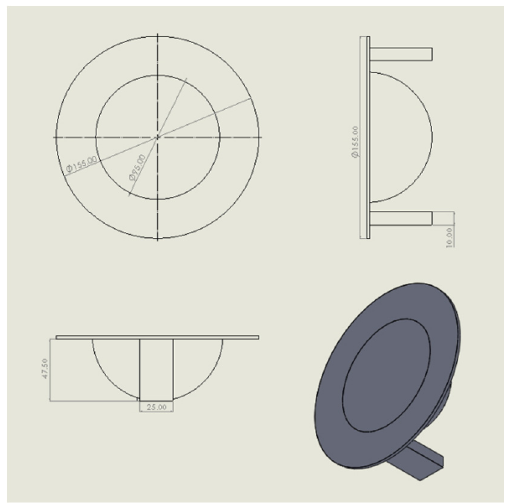
Figure 1. Three-dimensional engineering drawing of mold A). Unit: mm. Simulated tumors: A rubber glove finger filled with colored solution was used to simulate cysts with a diameter of approximately 20 mm. Benign tumors were simulated using regularly shaped dried sweet potato and dried agar konjac with a diameter of 10 mm. The malignant tumor, which is the target of needle biopsy, was simulated using a pickled shallot carved into an irregular shape. Glandular tissue: Gelatin powder (40 g) was dissolved in 200 mL of 70 ◦ C tap water. The solution was mixed at 60 rpm for 5 min. The air bubbles were removed. Red and blue food coloring was added to give the gel solution an opaque appearance. The gel solution was poured into mold A until it was 90% full to simulate the breast contour. The gel solution was refrigerated at 4 ◦ C for 30 min until it reached a semi-molten consistency. The simulated tumors (Figure 2a) were placed shallow in the mold. The gel solution was poured into the mold again until it was fully filled to cover the simulated tumors. The semi-molten gel was then refrigerated for another 2 h. The completely solidified glandular tissue was removed from the mold and prepared for use later. Fat tissue: Gelatin powder (15 g) was dissolved in 300 mL of 70 ◦ C tap water. The solution was mixed at 60 rpm for 5 min. Air bubbles were removed. Red and blue food coloring was mixed in to give the gel solution an opaque appearance. A height of 12.5 mm from the base of mold B was marked. The gel solution was poured into mold B up to the marked line (Figure 2b). The gel solution was refrigerated for 30 min at 4 ◦ C. Solidified glandular tissue from mold A was placed on top of the solidified gel in mold B and it was made sure that the space between mold B and the glandular tissue was uniform (12.5 mm for spacing distance), as depicted in Figure 2b. Gel solution was poured into the mold again until the uniform space between mold B and the glandular tissue was fully filled. The gel solution was refrigerated for another 4 h until it had completely solidified. A successfully developed multilayered breast phantom embedded with simulated tumors is shown in Figure